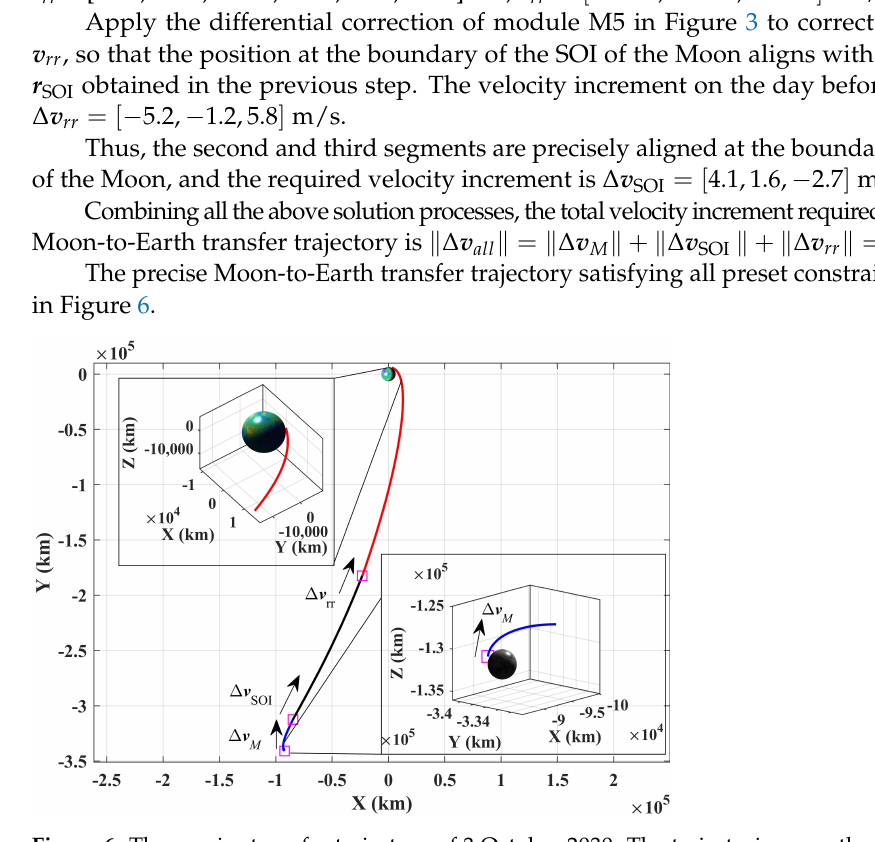
Figure 6. The precise transfer trajectory of 3 October 2030. The trajectories near the Earth and the Moon are also shown in magnified form. The three maneuvers divide the entire trajectory into three